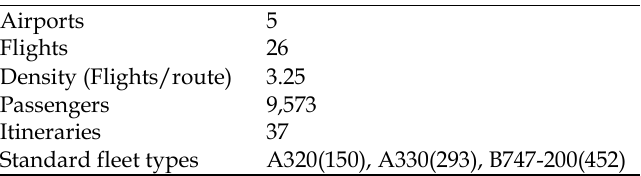
Table 6. Data instance for the hub-and-spoke